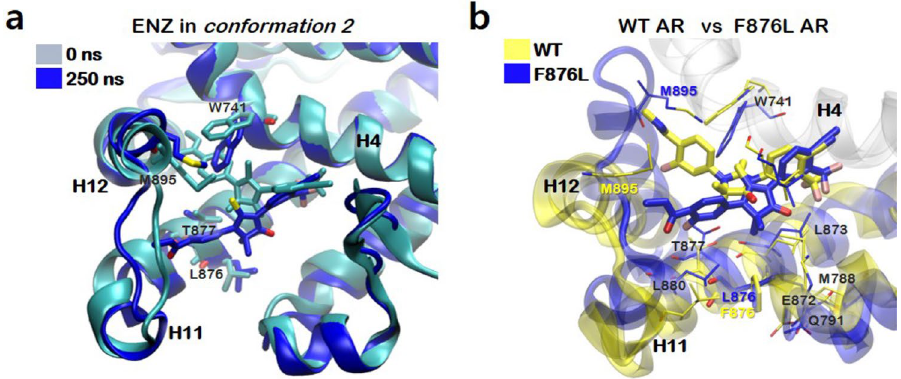
Figure 7. Conformational dynamics of the F876L mutant AR bound to ENZ in conformation 2 . ( a ) Comparison of the ligand binding pocket at 0 and 250 ns. Initial structures are colored in cyan and simulated structures with ENZ in conformation 2 are colored in blue. ( b ) Comparison of the ligand binding pocket of the wild type (yellow) and F876L mutant ARs (blue) bound to ENZ in conformation 2 after 250 ns aMD simulation. Images were created by using VMD v1.9.3 52 .